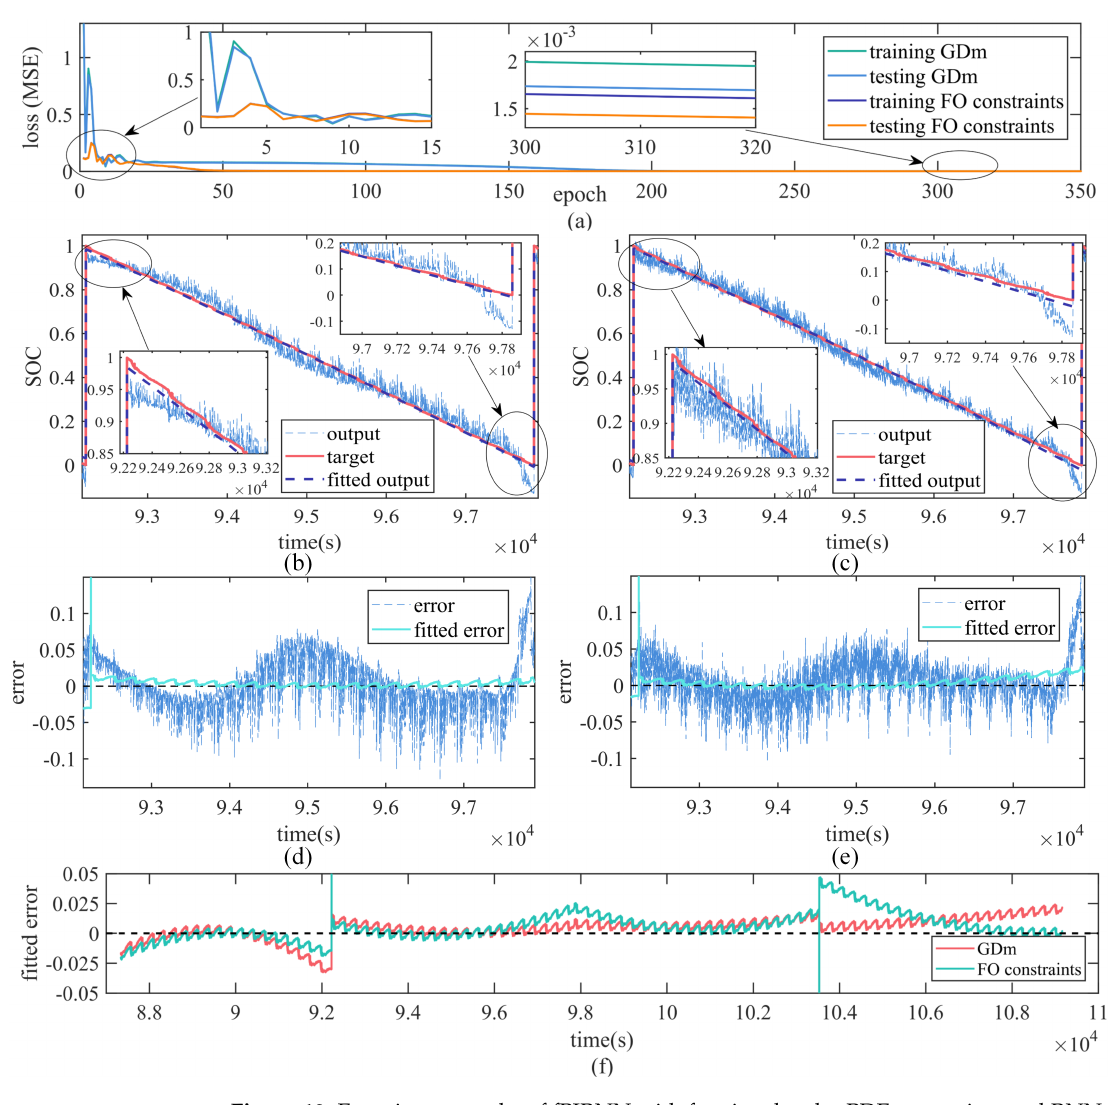
Figure 10. Experiment results of fPIRNN with fractional-order PDE constraints and RNN with GDm. ( a ) training and testing loss (marked as “training GDm”, “testing GDm”,“training FO constraints”, and “testing FO cosntraints”), ( b ) estimated SOC with GDm, ( c ) estimated SOC with FO constraints, ( d ) estimated error with GDm, ( e ) estimated error with FO constraints, and ( f ) comparison of fitted errors.